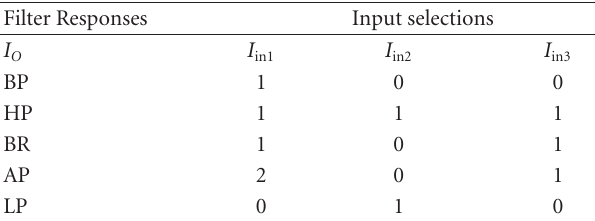
Table 2: The I in1 , I in2 , and I in3 values selection for each filter func- tion